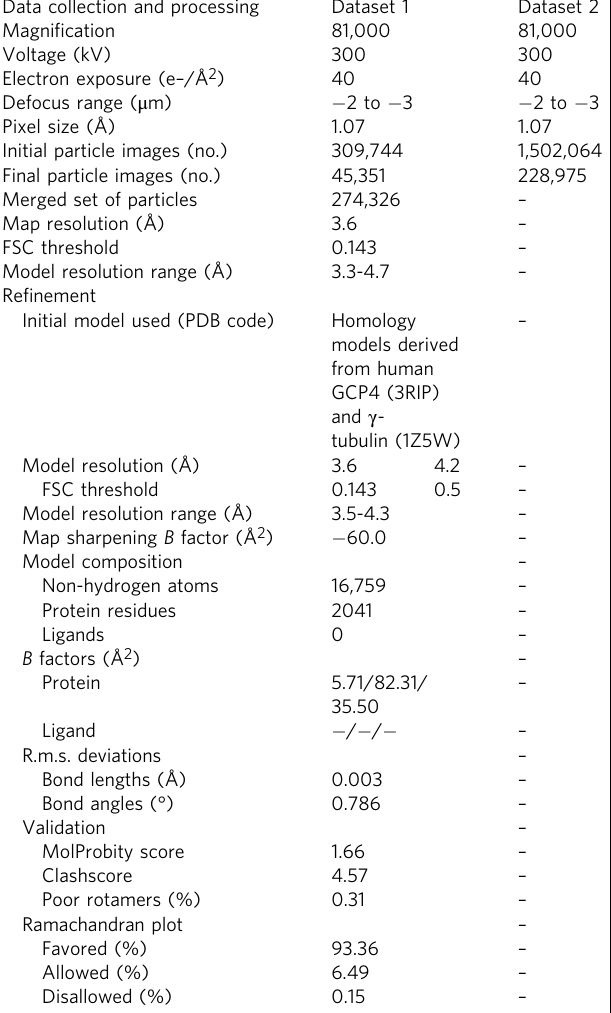
Table 1 Cryo-EM data collection, re fi nement and validation statistics.